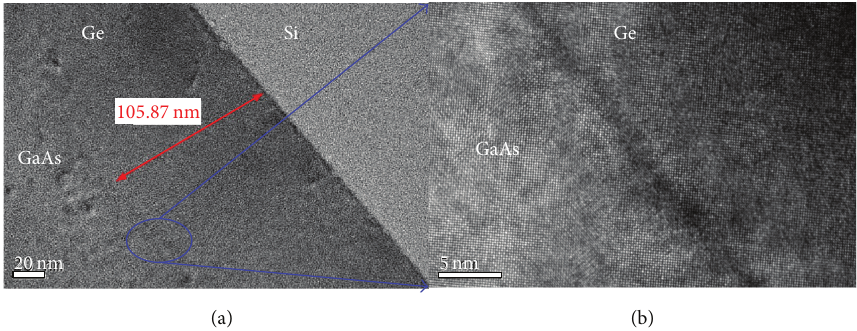
Figure 6: High resolution cross-sectional TEM image of the GaAs/Ge/Si (a) interface and (b)